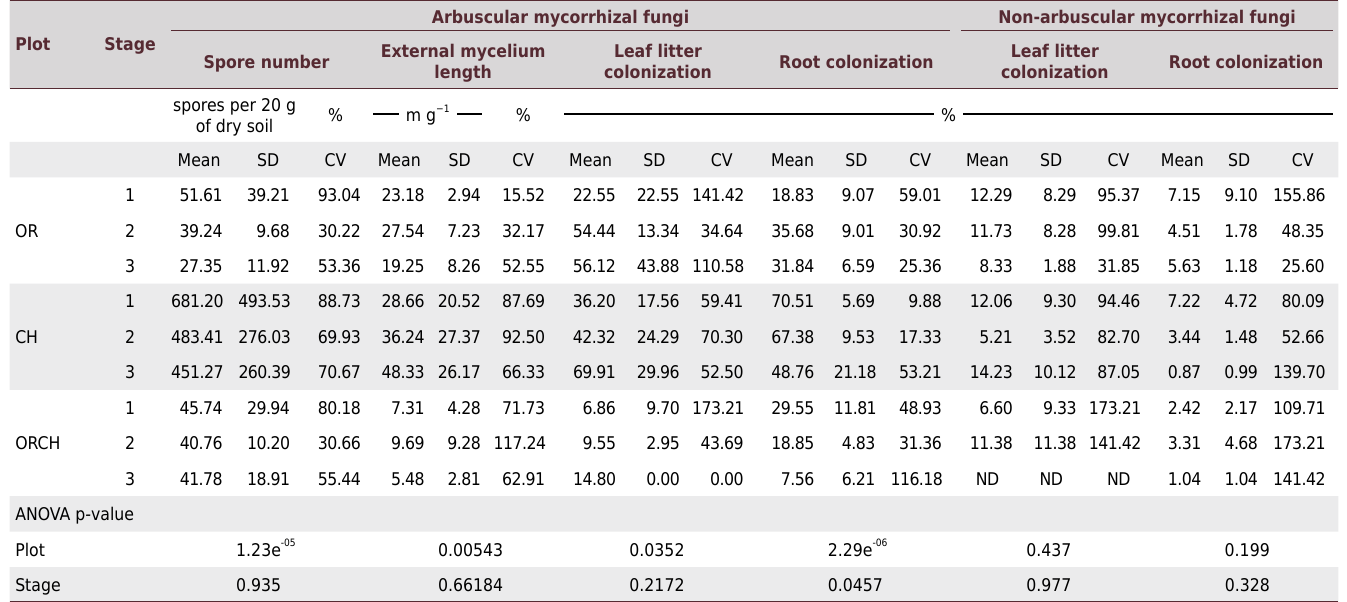
Table 4. Fungal parameters from the plots sampled at three different stages of leaf litter decomposition Plot Stage